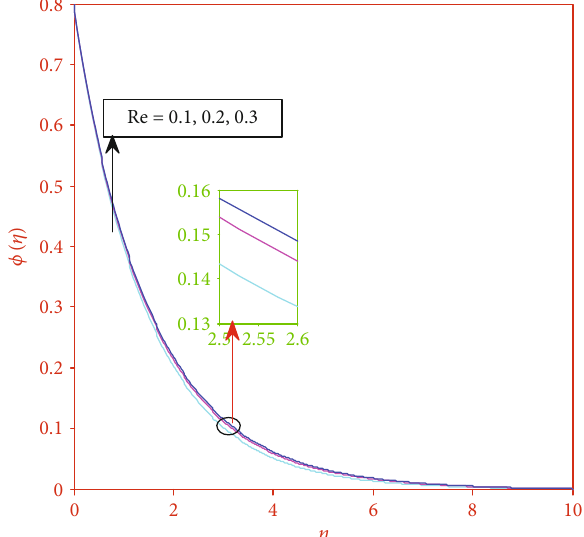
Figure 25: Concentration distribution for di ff erent values of the Reynolds number.